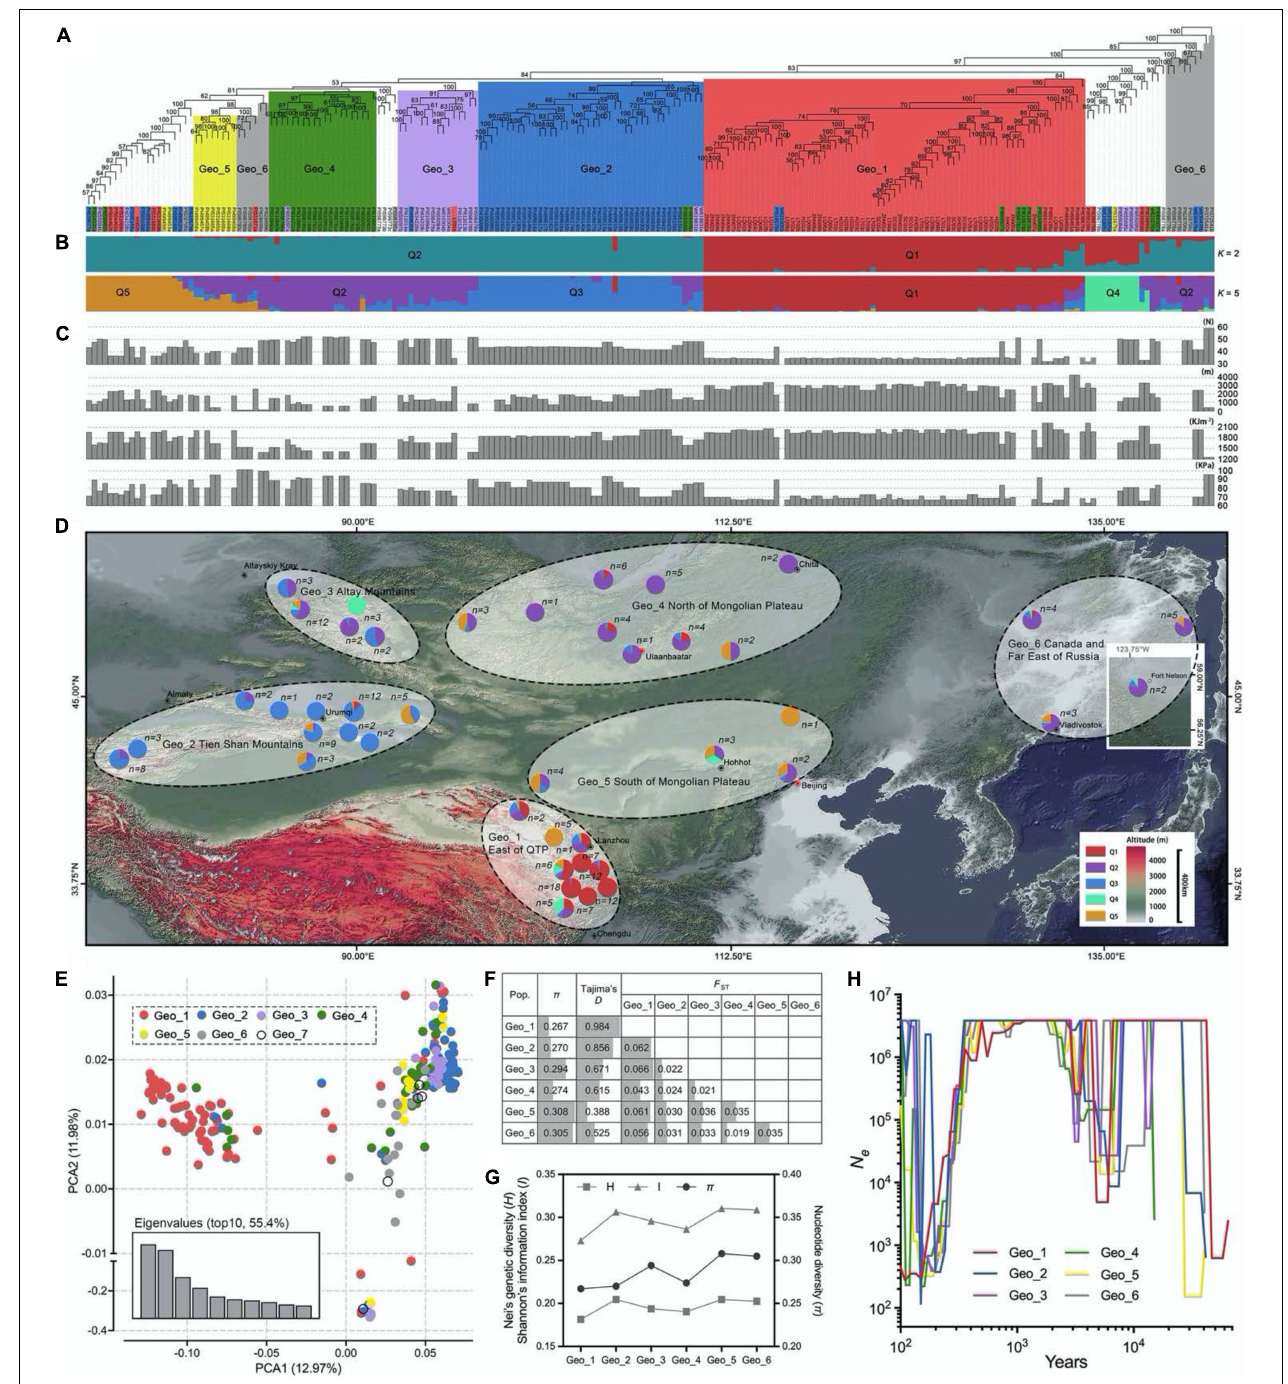
FIGURE 1 | Population structure, geographic distribution, and genetic diversity analysis by using 88,506 high-consistent single nucleotide polymorphisms (SNPs). (A) The neighbor-joining (NJ) phylogenetic tree of 210 Elymus sibiricus individuals was constructed with 88,506 SNPs. The different colors, respectively, represent the six geographical populations. Only bootstrap values higher than 50% are presented. (B) Population genetic structure of E. sibiricus germplasms when the K -value was two and five. (C) Geographic and climatic information for each germplasm, including latitude, altitude, UV-B, and surface pressure. Each bar of (B,C) corresponded to every individual in (A) . (D) Geographical distribution of E. sibiricus samples. The pie chart in the map represents the genetic structure proportion of each accession based on the population structure analysis ( K = 5). (E) Scatter plots of the first two principal components. (F) Genetic diversity analysis among six populations. (G) Genetic diversity relationships of expressed sequence tag-derived simple sequence repeat marker (EST-SSR)-based Nei’s genetic diversity (H) and Shannon’s information index (I) , as well as SNP-based nucleotide diversity ( π ) among six E. sibiricus populations. (H) Demographic histories of wild E. sibiricus groups. Data are shown the estimates of effective population size ( N e ) from about 70 Kya for the six groups.